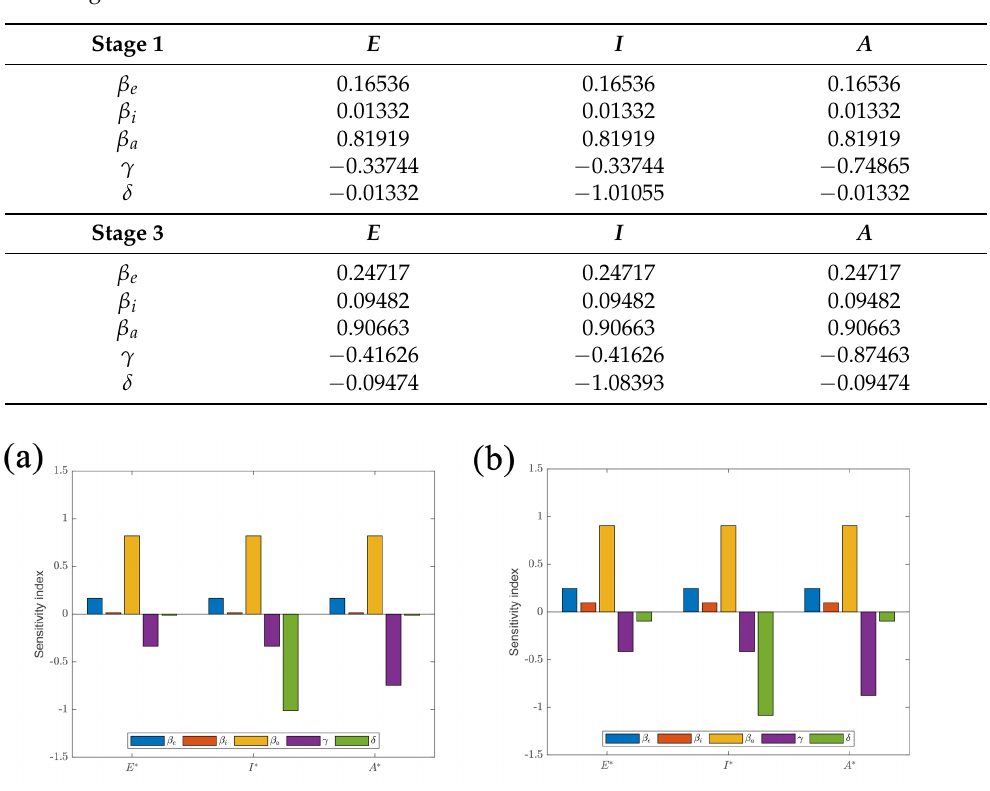
Figure 6. Sensitivity indices of EE to the model parameters in ( a ) stage 1 with R 0 = 2.1014 and ( b ) stage 3 with R t = 1.8004.